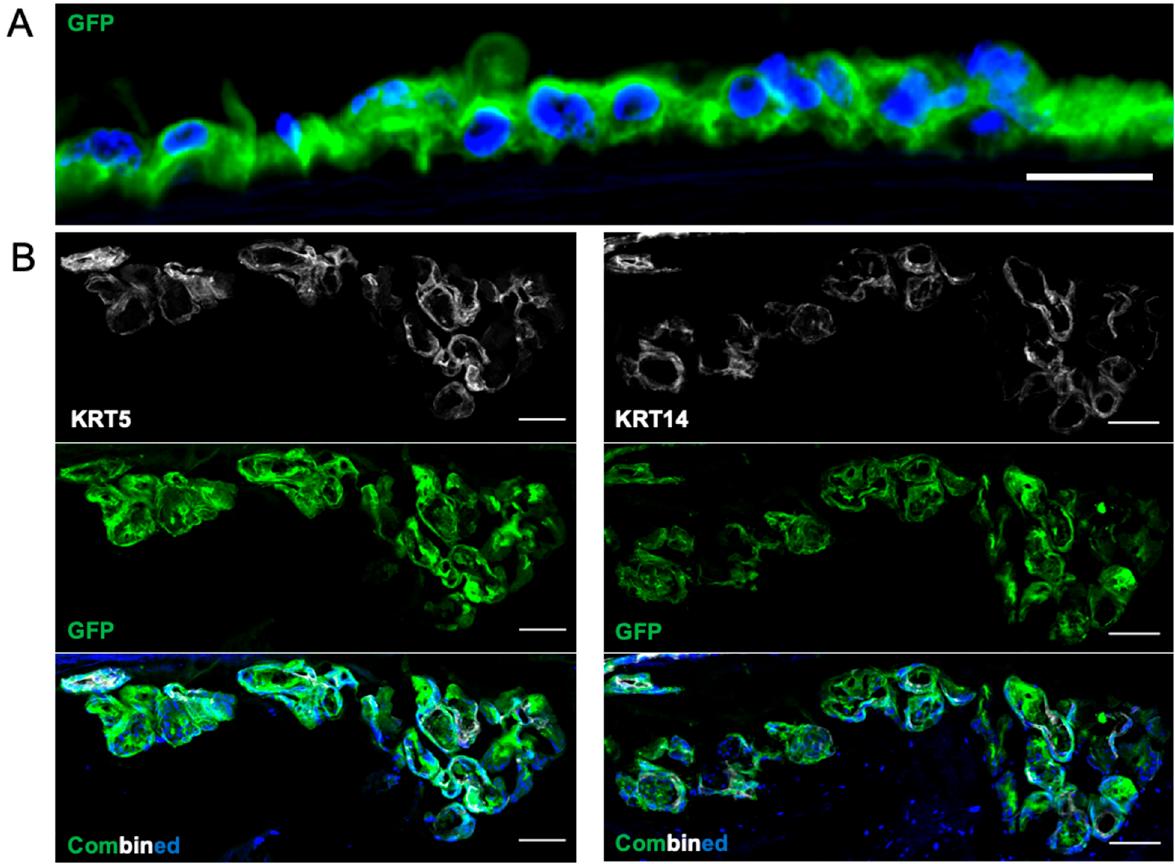
Figure 10. Murine myoepithelial cell recellularization on Day 8. ( A ) Surface MuMECs continued to remain mostly in monolayer without any morphologic change representing differentiated cells. ( B ) Submucosal glands were completely colonized by GFP-positive MuMECs with retention of the basal cell markers: KRT5 and KRT14. There was no differentiation into mucous or serous cells nor reversion into α‐ smooth muscle actin ‐ positive MuMECs.